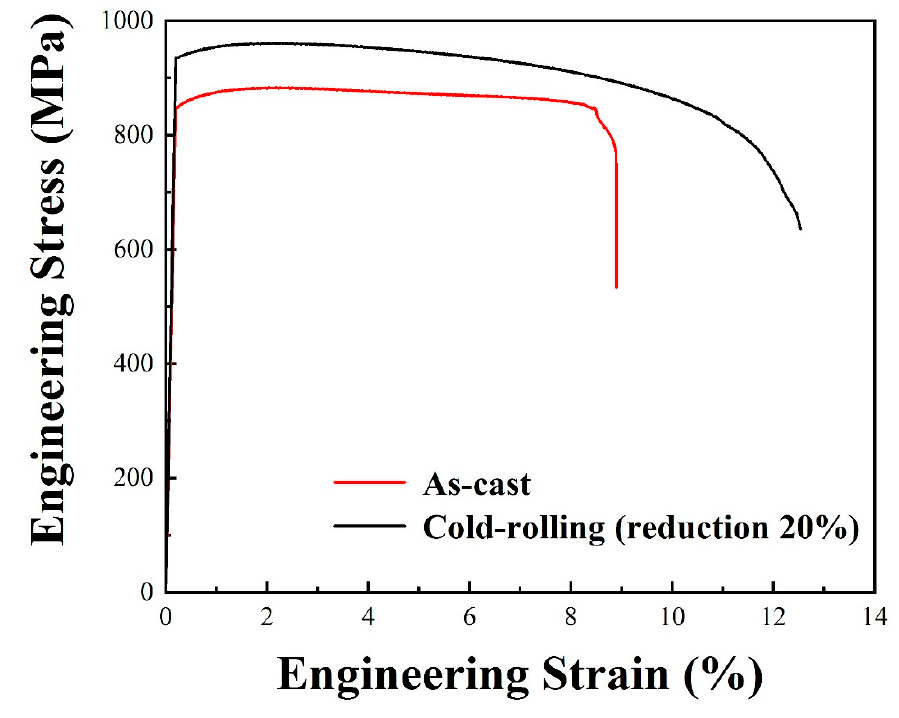
Figure 7. Tensile engineering stress–strain curves for the (TiZr) 0.8 (NbTaV) 0.2 RHEA at room temperature.